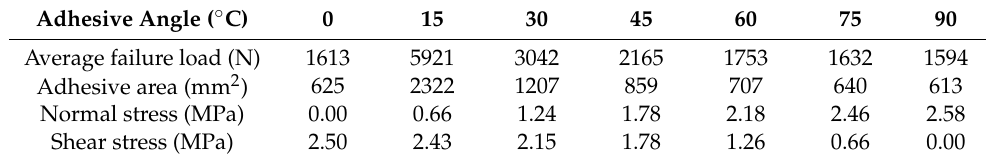
Table 8. Failure strength values of seven groups of adhesive specimens at different angles at 40 ◦ C.